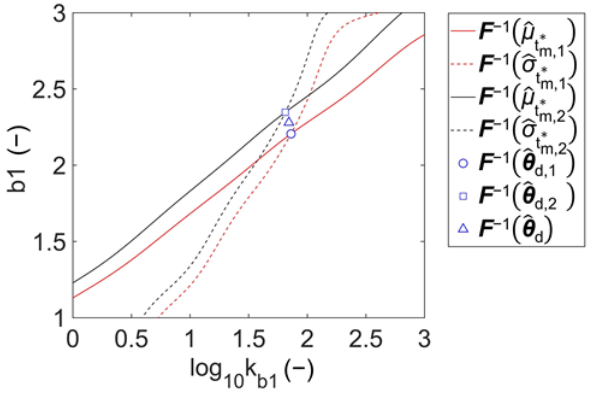
Figure 7. The outline of the estimation of the kinetic parameters of the stochastic primary nucleation.